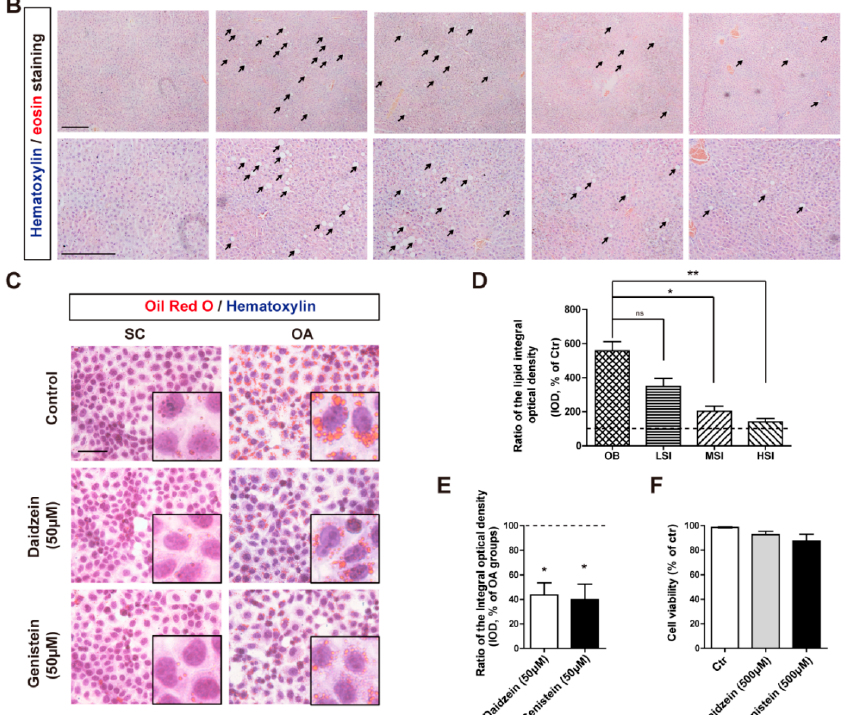
Figure 2. Soy isoflavones suppress the lipid accumulation in vivo and in vitro . ( A ) Representative images of Oil Red O staining show the accumulation lipid in the liver of rats feed with different diets. The insets show enlarged lipid droplets. Bar: 50 μ m; ( B ) Representative images of H and E staining show the steatosis (arrow indicated) in the liver of rats feed with different diets. Bar: 100 μ m; ( C ) Representative images of Oil Red O staining show the accumulation lipid, induce by 1 mM OA for 24 h, following a 24 h daidzein and genistein treatment in HepG2 cells. SC, solvent control; OA, oleic acid. The insets show enlarged lipid droplets. Bar: 50 μ m; ( D ) Quantification shows a significant decrease in the ratio of the lipid integral optical density between OB groups and soy isoflavone-addition groups. The dashed shows the ctr; ( E ) Quantification shows a significant decrease in the ratio of the lipid integral optical density in daidzein- and genistein-treated HepG2 cells. * p < 0.05, ** p < 0.01; ( F ) Quantification shows the cell viability of HepG2 cells treated with daidzein and genistein. Error bars indicate SEM. n = 3.